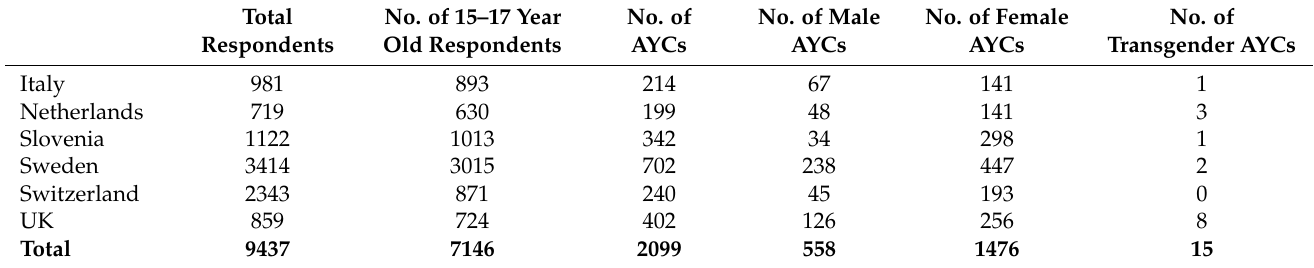
Table 3. Overview of respondent demographics across the six